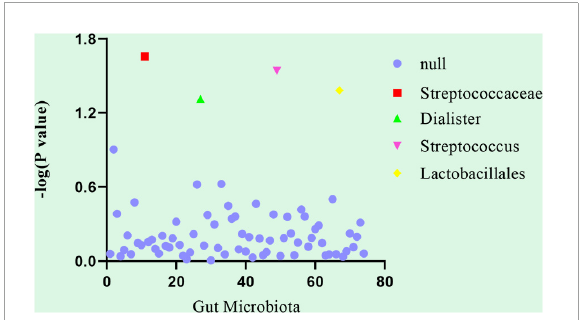
FIGURE1 Genetic correlation analysis between deep venous thrombosis and gut microbiota. Abscissa: the number of gut microbiota, arranged in number order for the gut microbiota (74 gut microbiota). Ordinate: P -value of the results of the genetic correlation analysis between deep venous thrombosis and gut microbiota. Null: The linkage disequilibrium score regression showed the gut microbiota that had no suggestive genetic correlation with deep venous thrombosis, that is, ineffective gut microbiota ( P -value >